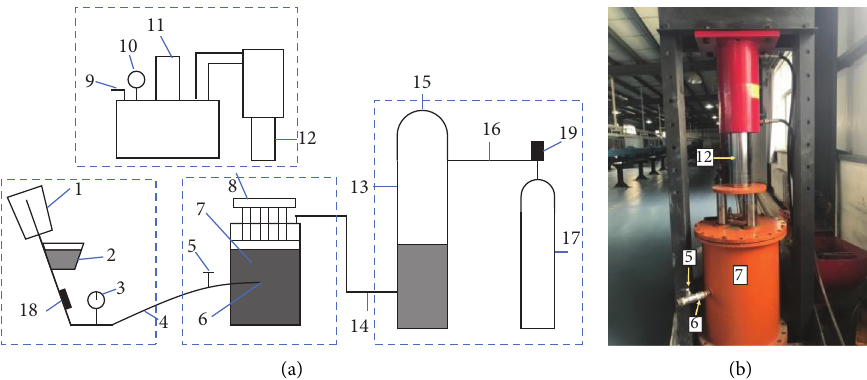
Figure 5: The experiment system of diffusion (a) diagram of devices and (b) experiment field.1: electronic motor. 2: slurry tank. 3: pressure